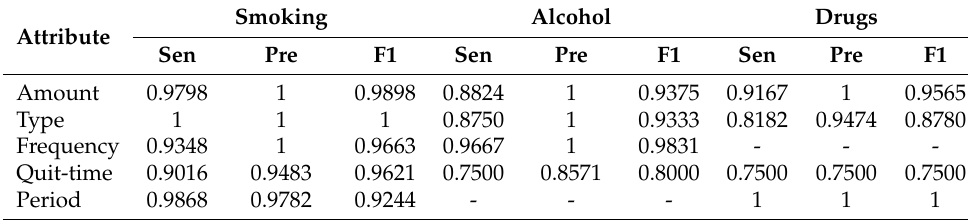
Table 7. Attribute extraction performance of the proposed